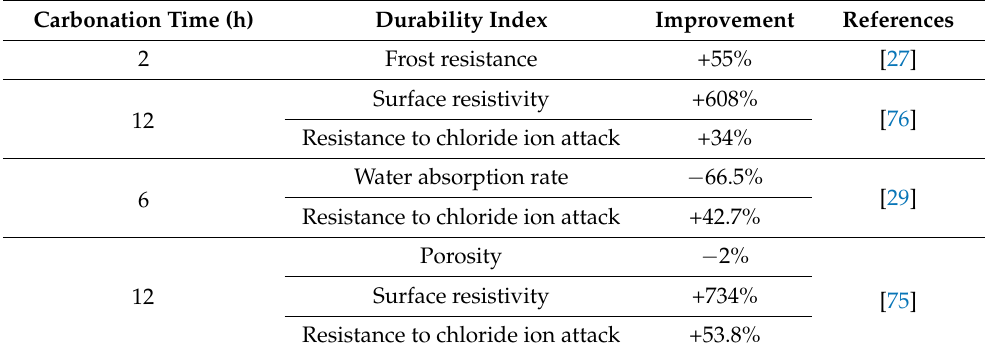
Table 1. Effect of carbonation curing on the durability of